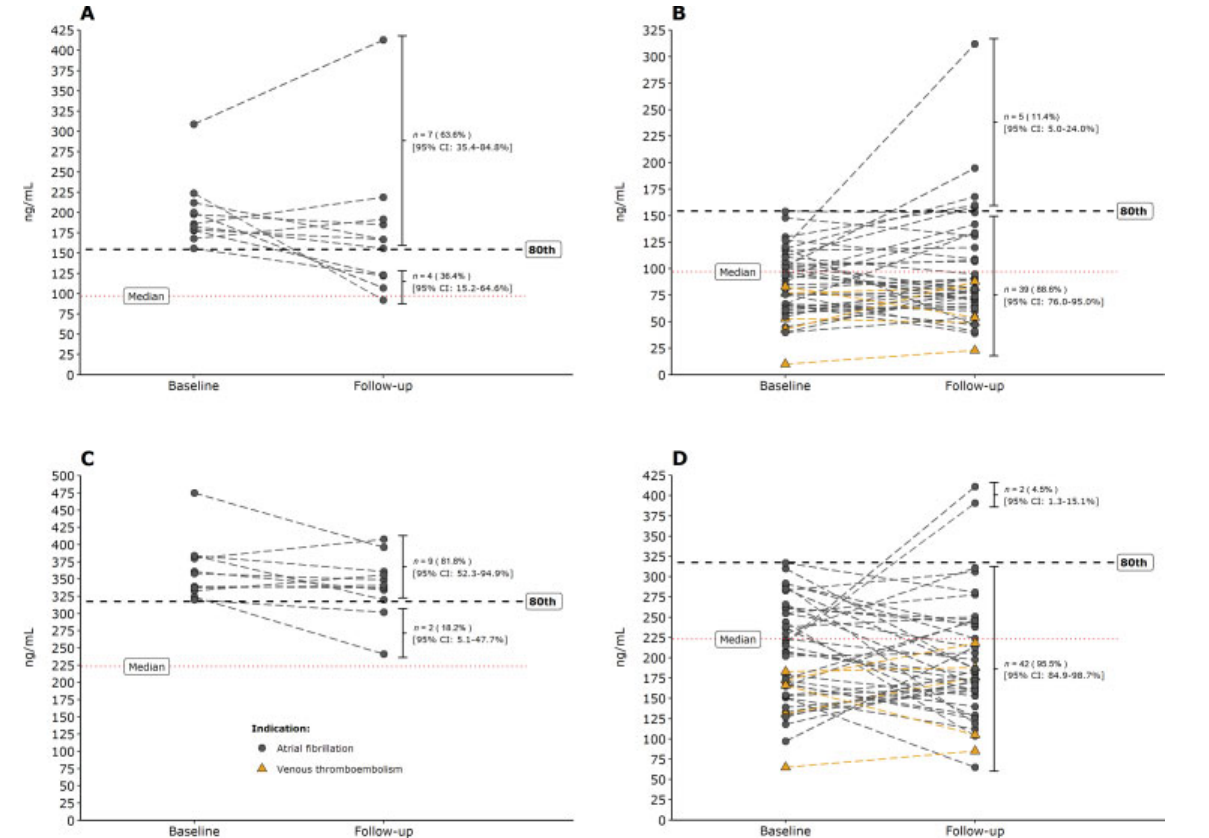
Fig. 3 Intrapatient variability of apixaban in patients treated with the 5-mg twice daily dose, with an initial level in or below the upper quintile: these graphs illustrate the intra-patient variability of the 55 patients treated with 5-mg twice daily apixaban, with an initial trough ( A and B ) or peak level ( C and D ) in or below the upper quintile of levels. The cut-offs for the upper quintile at the fi rst visit are 154.4 and 317.6ng/mL for trough and peak levels, respectively. CI, con fi dence